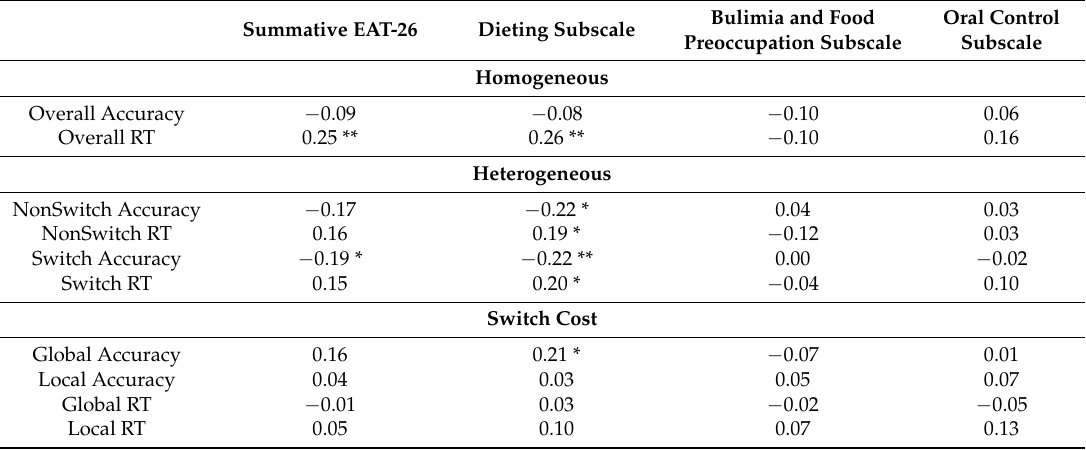
Table 2. Bivariate Correlations between EAT-26 variables and Switch task behavioral variables. Summative EAT-26 Dieting Subscale